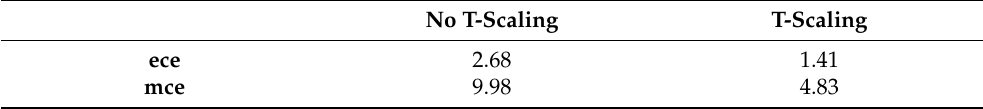
Table 1: Estimated and maximum calibration error (ece, mce).